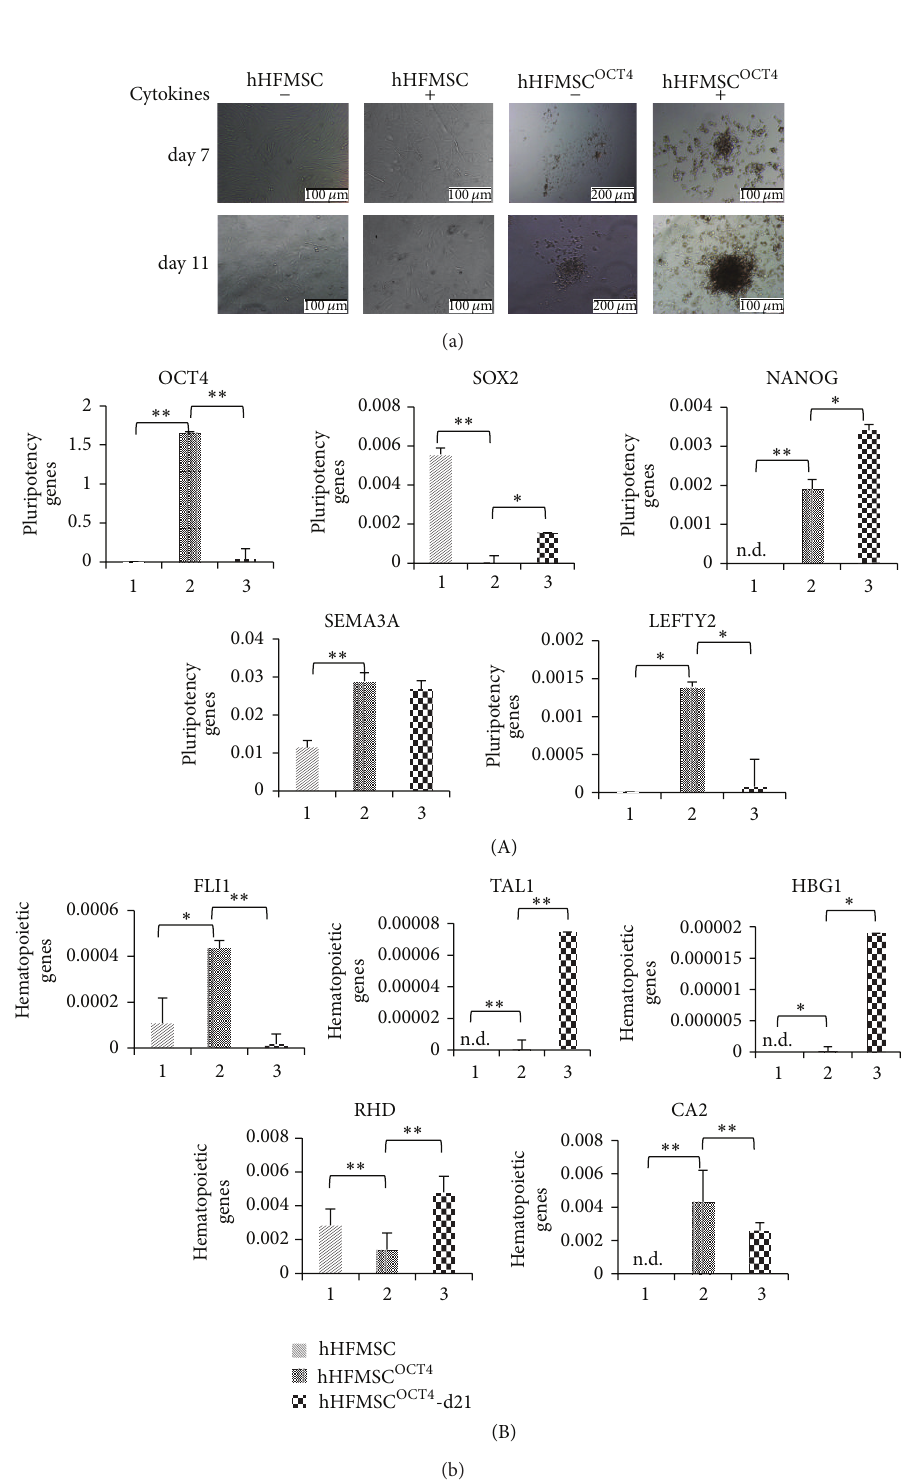
Figure 8: OCT4 gives hHFMSCs a potential for transdifferentiating into erythroid cells by triggering pluripotent state and reexpressing erythroid development genes. (a) OCT4 plays a critical role in transdifferentiation of hHFMSCs into erythroid cells. (b) RT-qPCR detection of OCT4 target genes in transdifferentiation of hHFMSC into erythroid cells. Exogenous OCT4 genes were transduced into hHFMSCs in manner of MOI: 160 (named hHFMSC OCT 4 ), and hHFMSCs OCT 4 -d21 were derived from hHFMSC OCT 4 by hematopoietic cytokines culture for 21 days. (A) Expression of OCT4 target genes associated with pluripotency. (B) Expression of OCT4 target genes associated with erythroid development. ∗ 𝑃 < 0.05 ; ∗∗ 𝑃 < 0.01 ; n.d.,